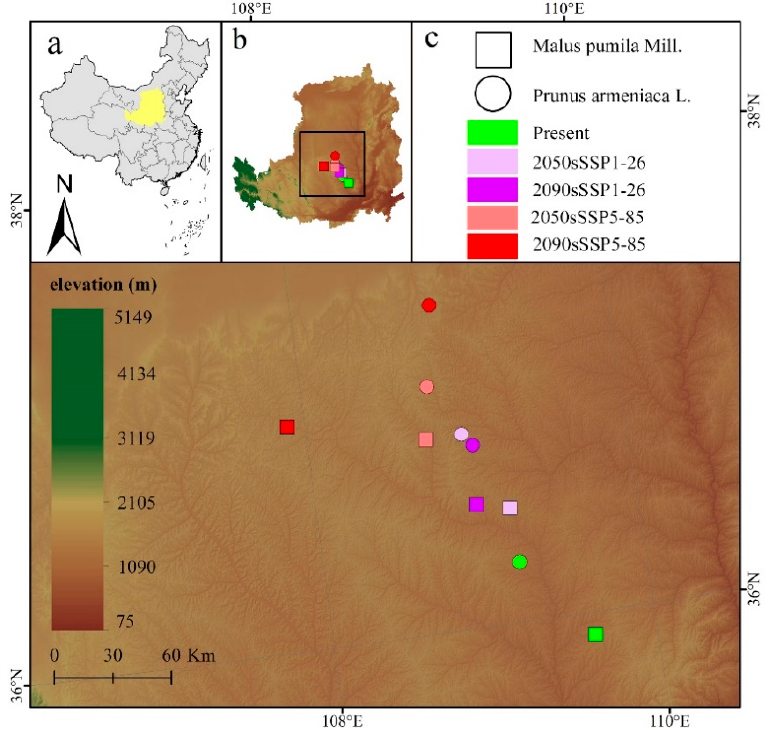
Figure 6. Suitable habitat centroids of Malus pumila Mill and Prunus armeniaca L. in present, 2050s and 2090s periods under the Shared Socioeconomic Pathways (SSPs) SSP1-26 and SSP5-85. ( a ) Yellow area shows the study area, the Loess Plateau, in relation to China. ( b ) Black box shows the locations of centroids in relation to the Loess Plateau. ( c ) The colored dots and squares correspond with the shape and